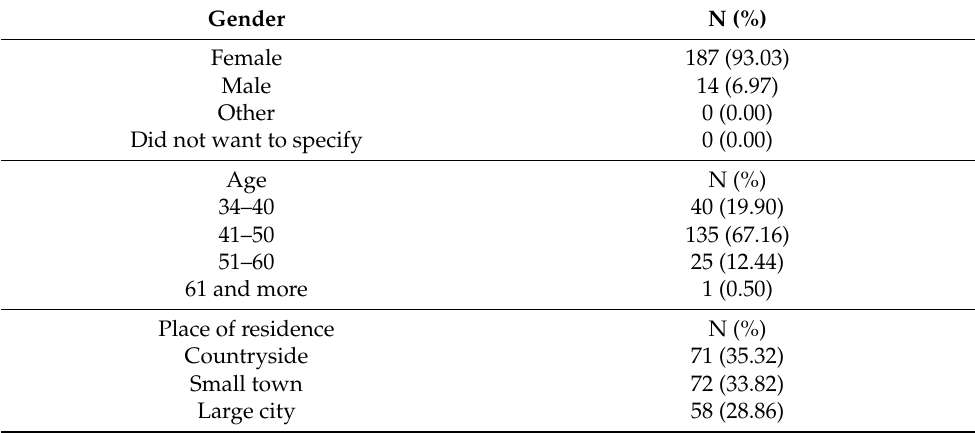
Table 2. Socio-demographic characteristics of parents.